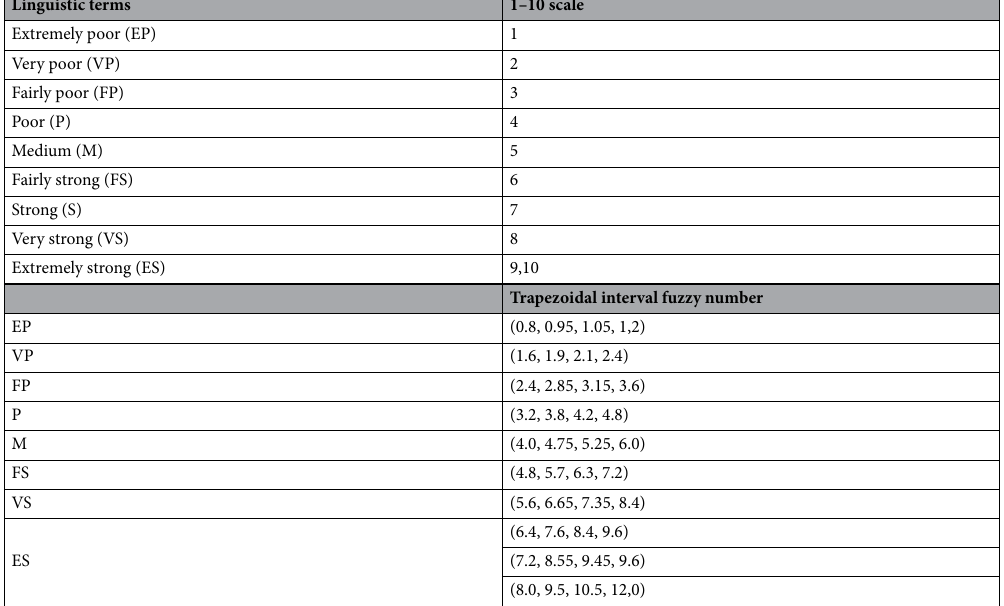
Table 2. Linguistic terms and their expression based on